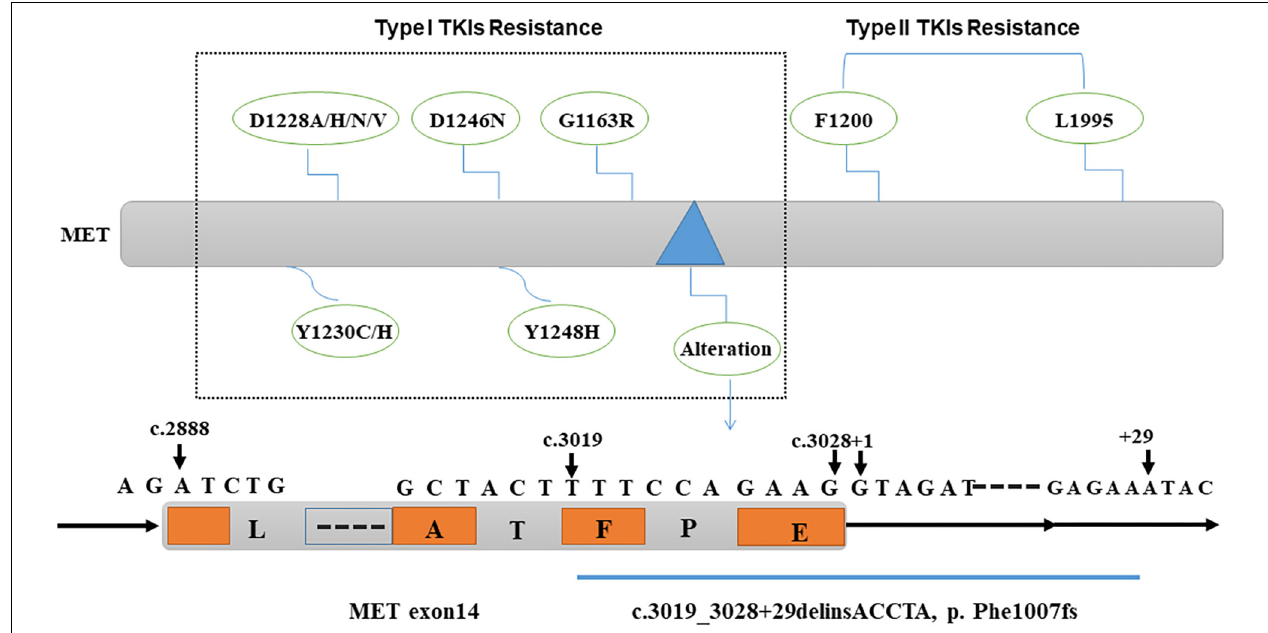
FIGURE 1 | Genomic alteration causing resistance to MET-targeted therapy. MET gene mutations D1228A/H/N/V, D1246N, Y1230C/H, Y1248H, G1163R, and MET exon 14 “deleting and inserting” mutation (c.3019_3028 + 29delinsACCTA, p. Phe1007fs) cause resistance to type I MET-TKIs; MET gene mutations L1195 and F1200 are responsible for the resistance to type II MET-TKIs. TKIs, tyrosine kinase